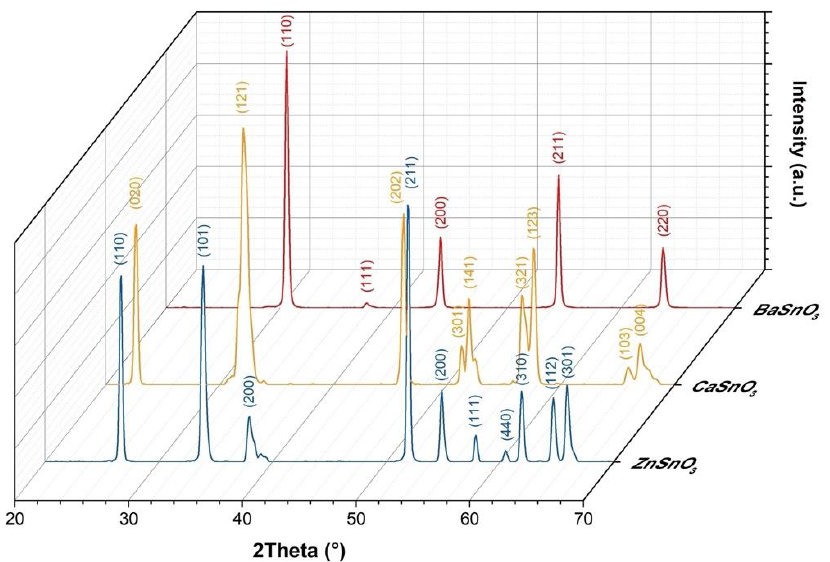
Figure 5. XRD patterns of sintered ceramic bodies based on MSnO 3 perovskites (M = Ba, Ca, Zn). The Raman spectra of the ceramic bodies of the MSnO 3 system (M = Ba, Ca, Zn) meas-